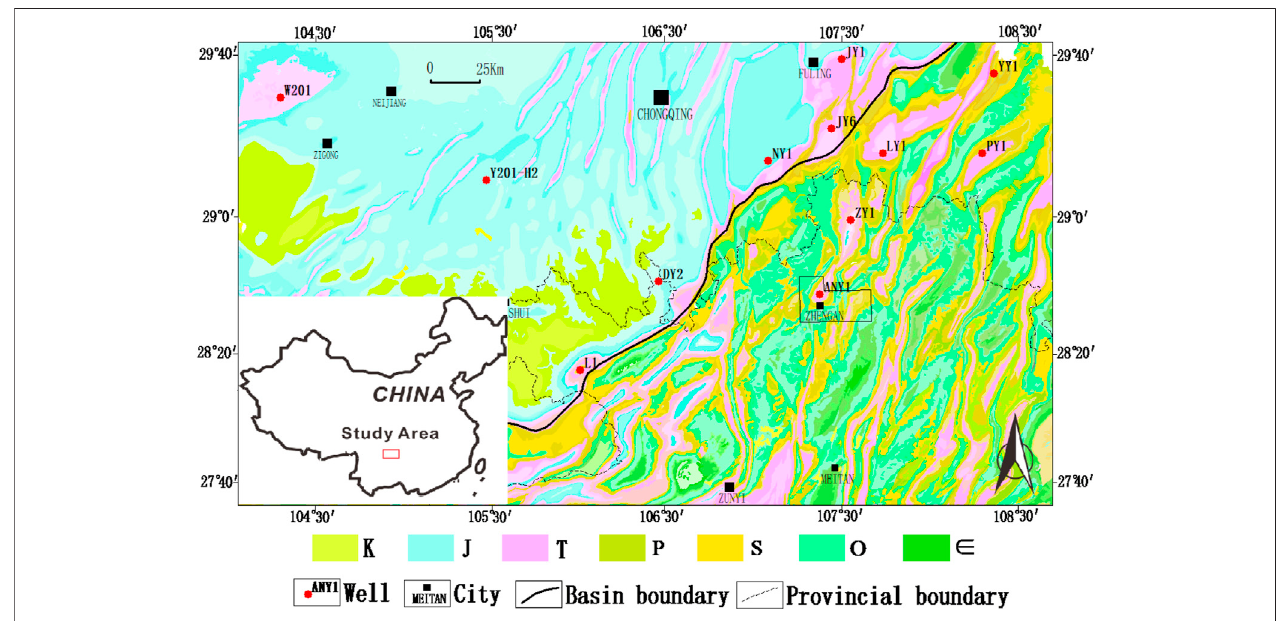
FIGURE 1 | Geological structure of Anchang